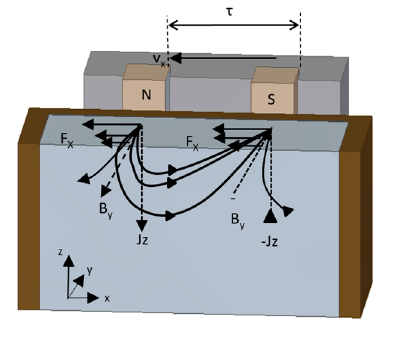
Figure 2. Working principle of the linear stirrer.